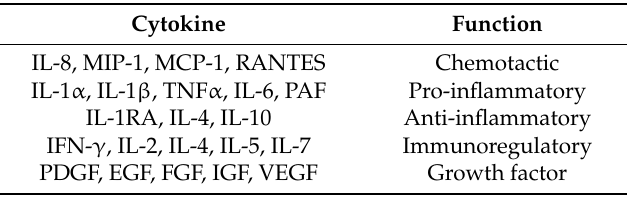
Table 1. Cytokines Linked to Oral